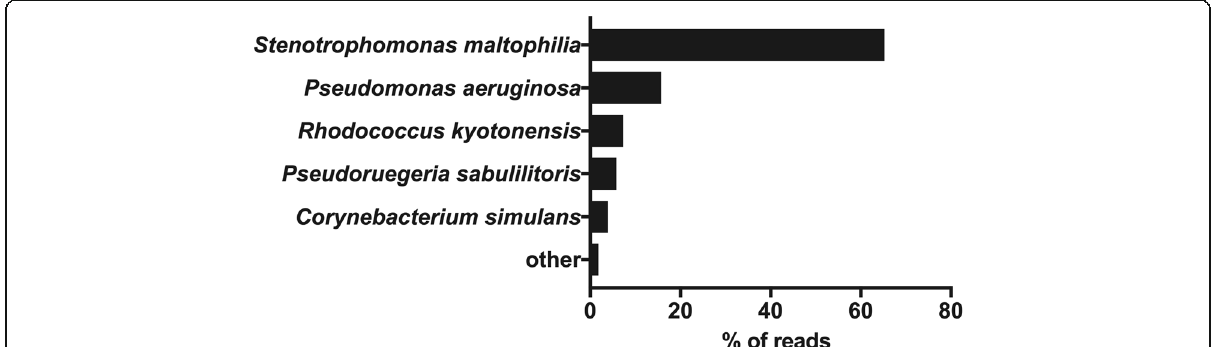
Fig. 1 Taxonomic assignment of the 16S rRNA genes in sputum samples. The samples were subjected to 16S rRNA amplicon sequencing using MinION ™ (Oxford Nanopore Technologies, Oxford, UK), and the percentage of reads (with the abundance over 2%) belonging to the identified bacterial species is shown. Sequencing for 5min generated 470,231 reads. A total of 41,136 reads were aligned with one of the bacterial 16S rRNA gene sequences, and 65.3% reads were aligned with Stenotrophomonas maltophilia and 15.7% reads were aligned with Pseudomonas